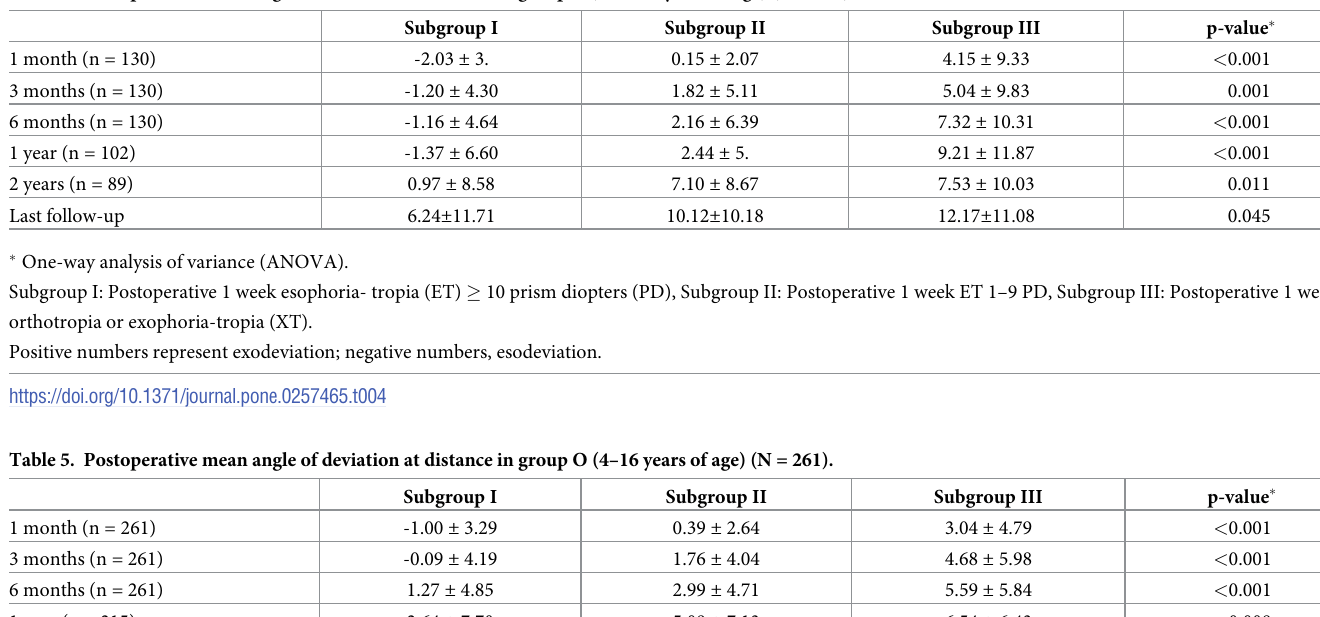
ence in the subgroup distribution was between groups Y and O (p = 0.133, Pearson’s chi- square test) (Table 3).